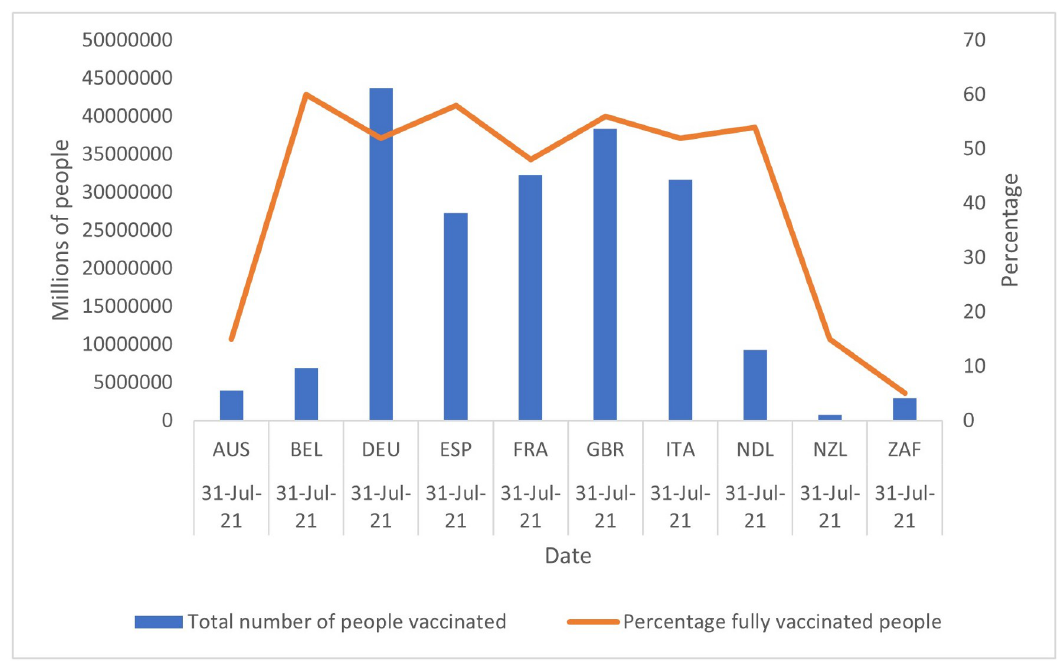
Fig 1. COVID-19 number of people vaccinated and the percentage of fully vaccinated people per country (31 July 2021). Source: Mathieu et al. [13].